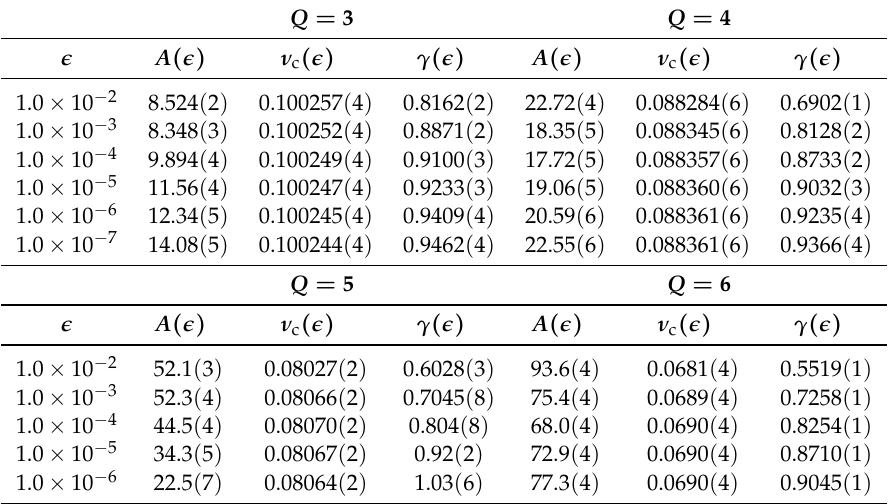
Table 4. Estimates of fit parameters for T cons ( ν , (cid:101) ) for Q > 2.